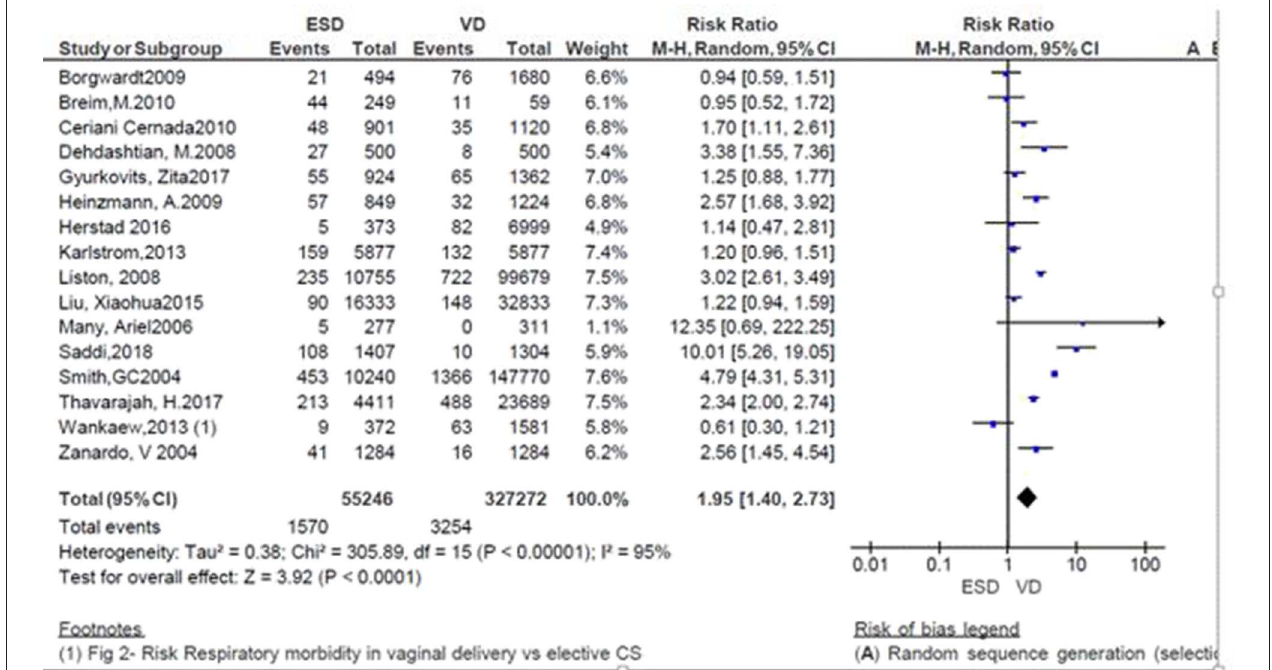
ECS in high and middle-income countries ( RR = 1.91;